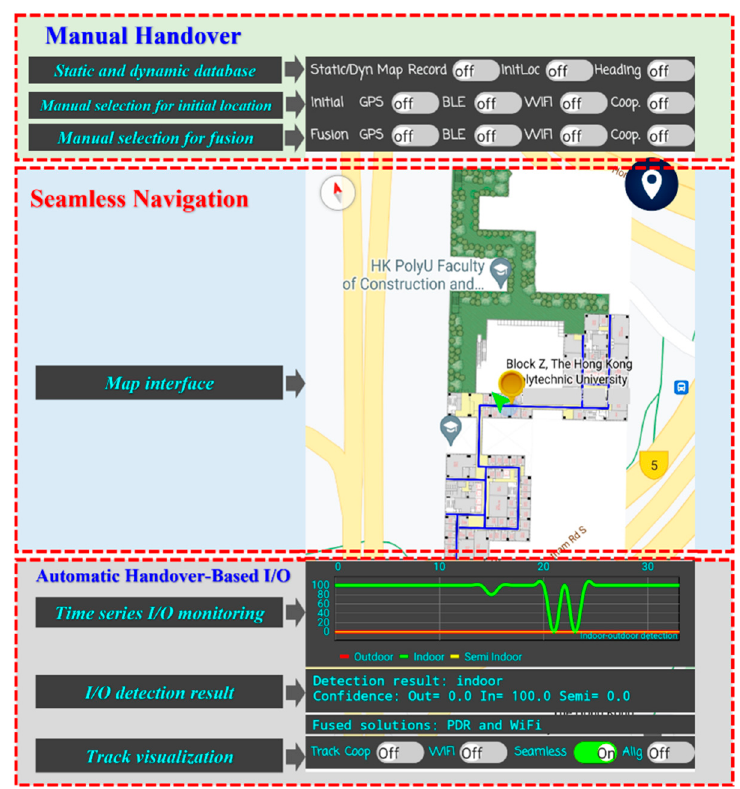
Figure 2. The prototype application developed for seamless and ubiquitous navigation.